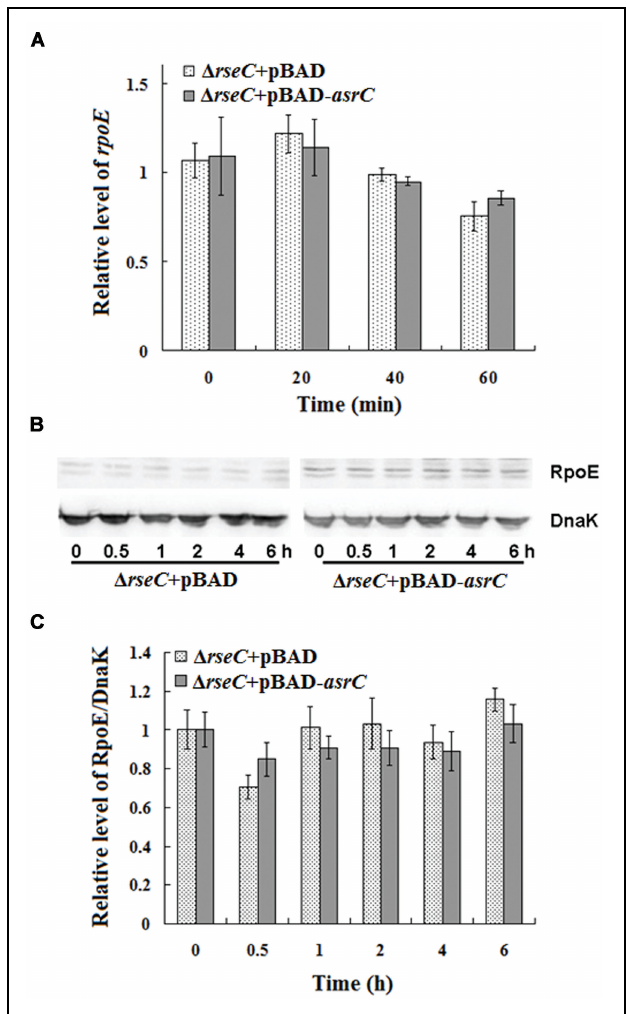
FIGURE 7 | Expression of rpoE mRNA and protein in rseC mutant strain after overexpression of AsrC. (A) qRT-PCR for rpoE mRNA levels in (cid:2) rseC + pBAD and (cid:2) rseC + pBAD- asrC strains. Total RNA was isolated from (cid:2) rseC + pBAD and (cid:2) rseC + pBAD- asrC strains grown to OD 600 0.4 at 0 min, 20 min, 40 min, and 60 min after addition of L -arabinose (0.2% final concentration). Levels of 5S rRNA were the internal reference. (B) Western blot of RpoE protein relative to DnaK in (cid:2) rseC + pBAD and (cid:2) rseC + pBAD- asrC strains. (C) Quantitation of RpoE protein based on Western blots. Proteins were isolated from (cid:2) rseC + pBAD and (cid:2) rseC + pBAD- asrC strains grown to OD 600 0.4 at 0 h, 0.5 h, 1 h, 2 h, 4 h and 6 h after addition of L -arabinose (0.2% final concentration). Experiments were repeated three times and error bars indicate standard deviations.